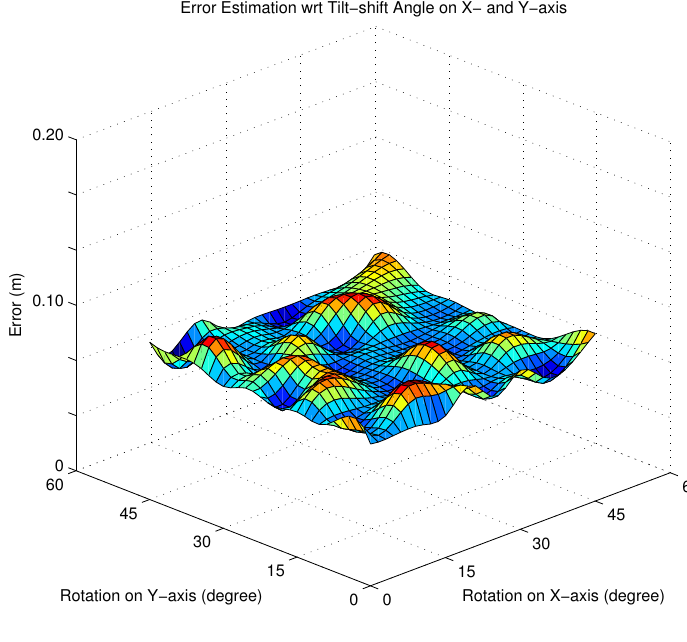
Figure 7. Estimated error with respect to the tilt